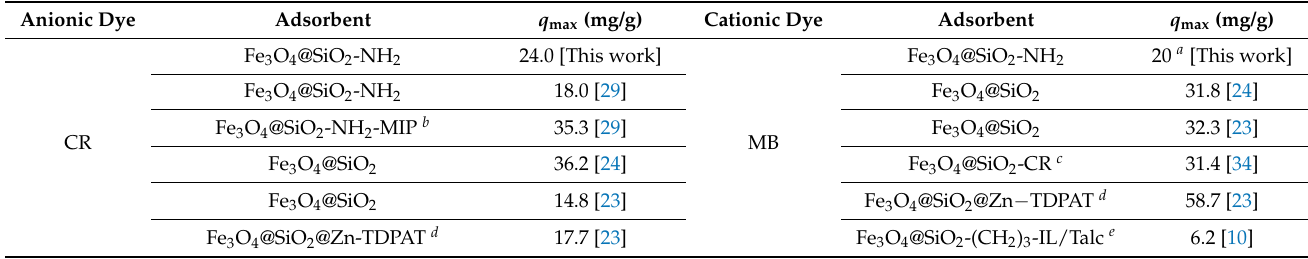
the electrostatic interactions are not only responsible for the adsorption of the dyes on NPs. Table 3. Comparison of the adsorption capacity of the Fe 3 O 4 @SiO 2 core-shell magnetic nanoparticles for the anionic CR and cationic MB dyes. Anionic